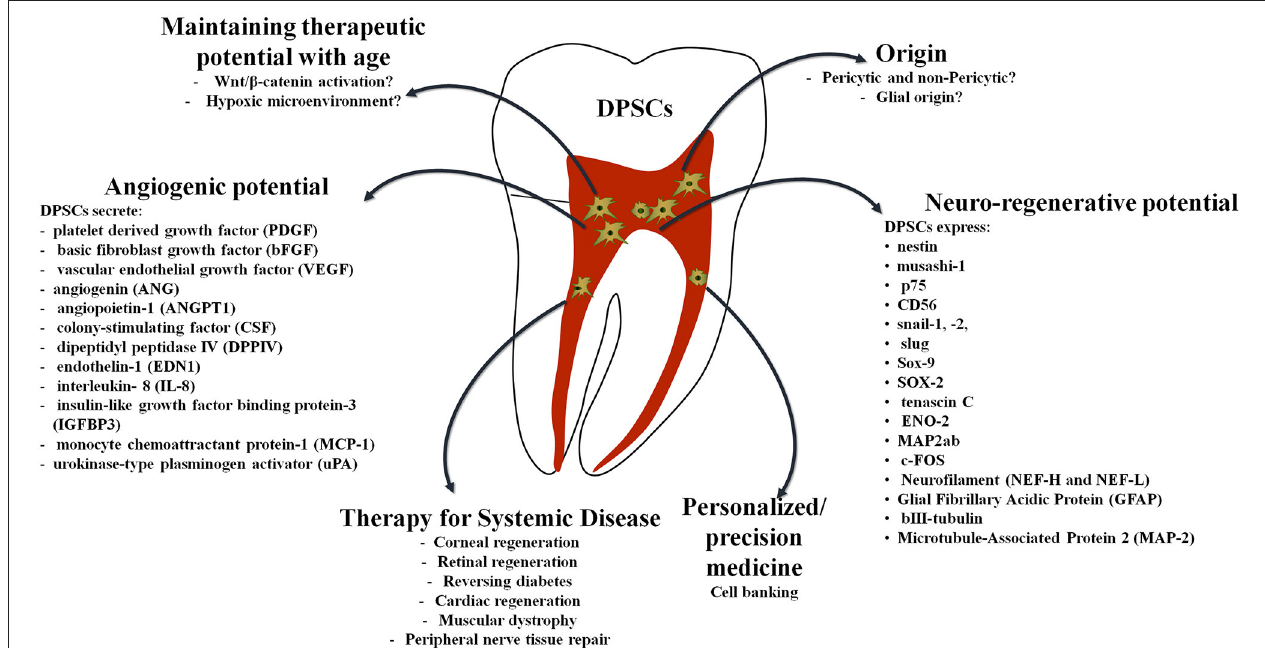
FIGURE 1 | Translational regenerative potential of dental pulp stem